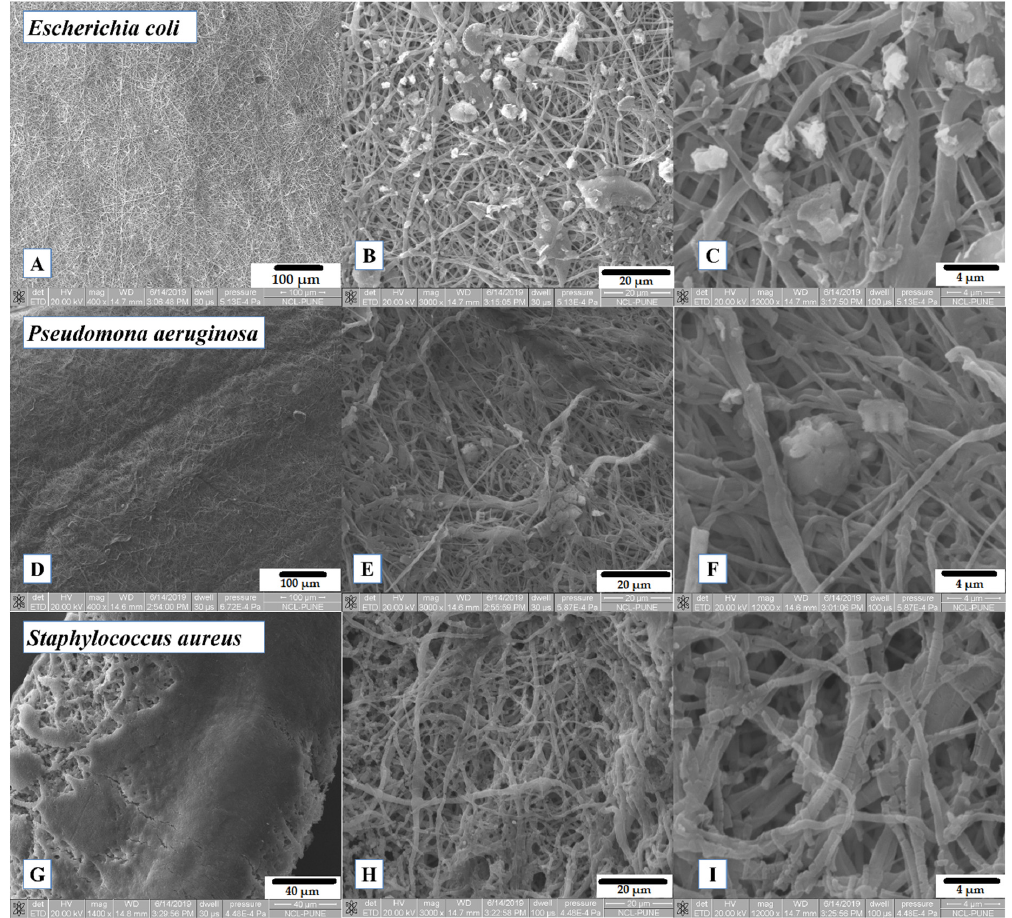
Figure 8. SEM images of exposed PCL/CUR4 scaffolds with bacteria after 12 h of incubation. ( A ) Escherichia coli on PCL/CUR4 fibers (400×); ( B ) Escherichia coli on PCL/CUR4 fibers (3000×); ( C ) Escherichia coli on PCL/CUR4 fibers (12,000×); ( D ) Pseudomonas aeruginosa on PCL/CUR4 fibers (400×); ( E ) Pseudomona aeruginosa on PCL/CUR4 fibers (3000×); ( F ) Pseudomona aeruginosa on PCL/CUR4 fibers (12,000×); ( G ) Staphylococcus aureus on PCL/CUR4 fibers (1400×); ( H ) Staphylococcus aureus on PCL/CUR4 fibers at (3000×); ( I ) Staphylococcus aureus on PCL/CUR4 fibers (12,000×).